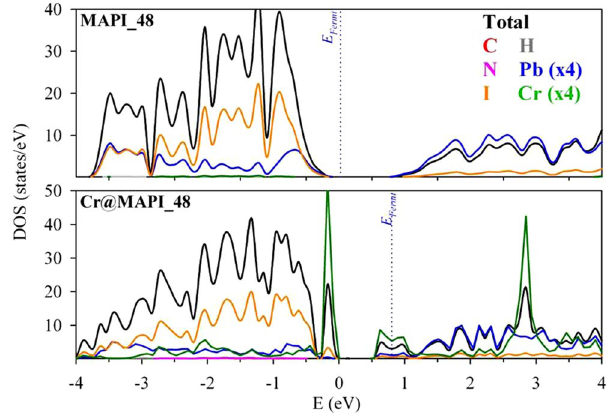
Figure 3. Projected Density of States of MAPI_48 and Cr@MAPI_48 calculated with PBEsol + SOC. The zero of energy has been set at the valence band energy, while blue dotted line is representing the Fermi level ( E Fermi ).